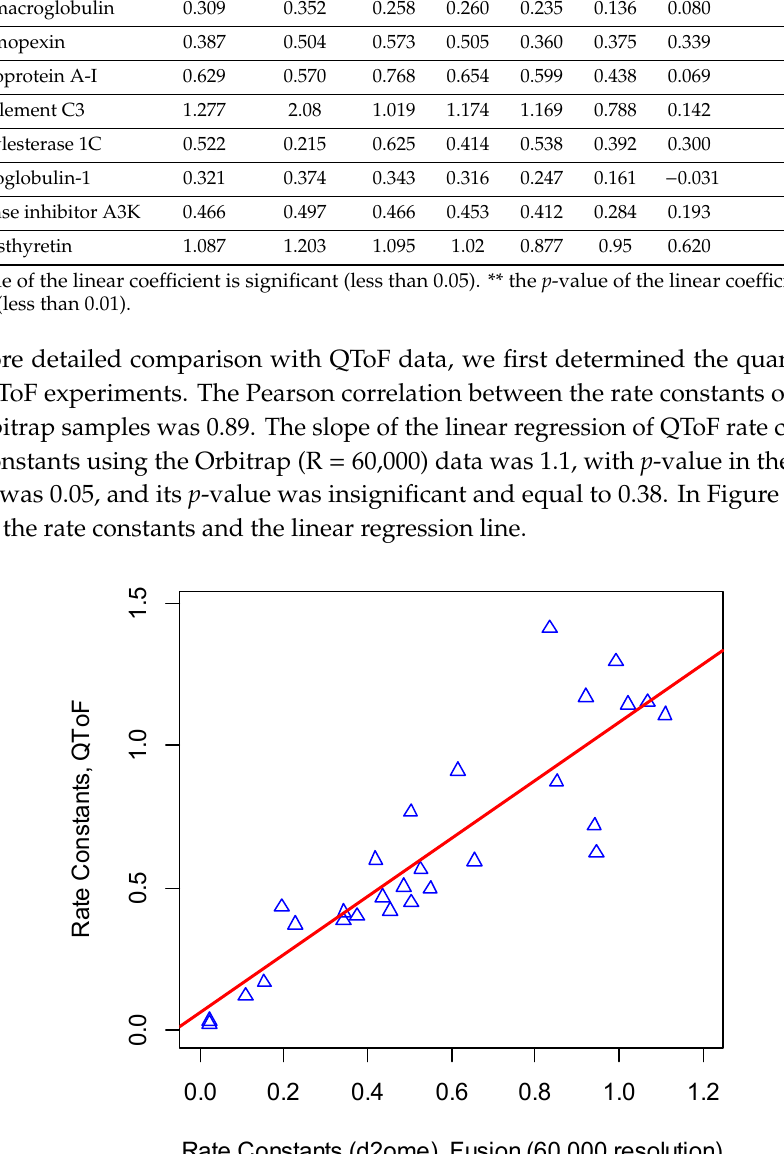
Figure 5. The proteome dynamics from QToF 10,000 resolution and Orbitrap 60,000 resolution were comparable. The scatter plot of the rate constants from QToF and Orbitrap Fusion.